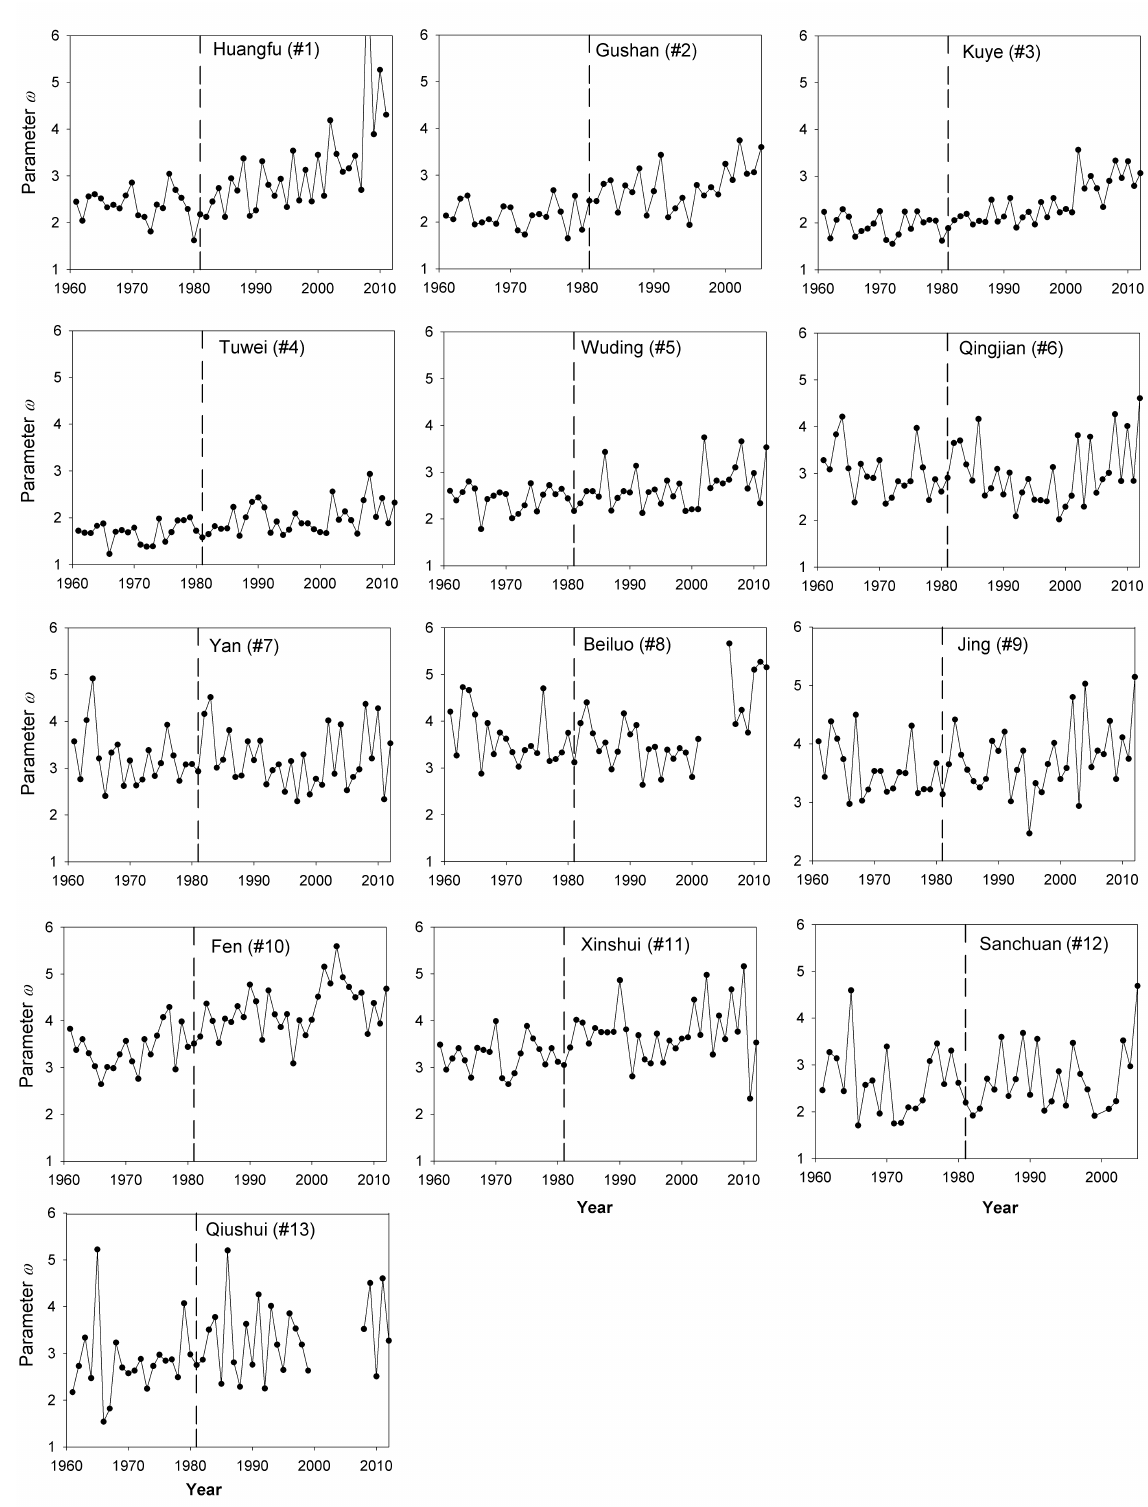
Figure 2. The variability of parameter ω for 13 basins between 1961 and